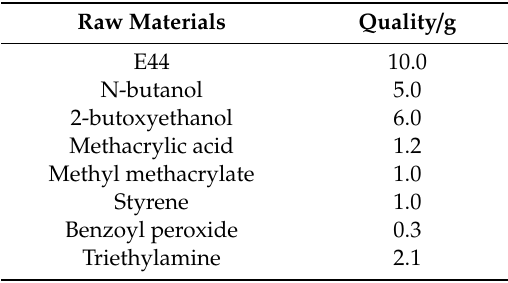
Table 1. Experimental details of waterborne epoxy emulsions (WEU)